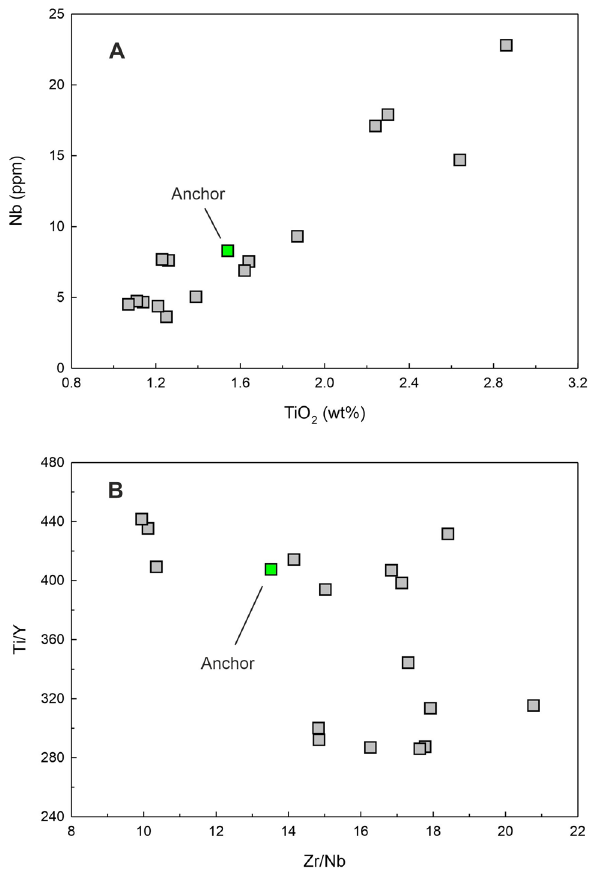
Figure 8. Cross plots of Nb vs. TiO 2 ( A ) and Ti/Y vs. Zr/Nb ( B ) for the Chilika Anchor rock compared with the data for Palitana lava flows (data source: Sheth et al., 2013) 16